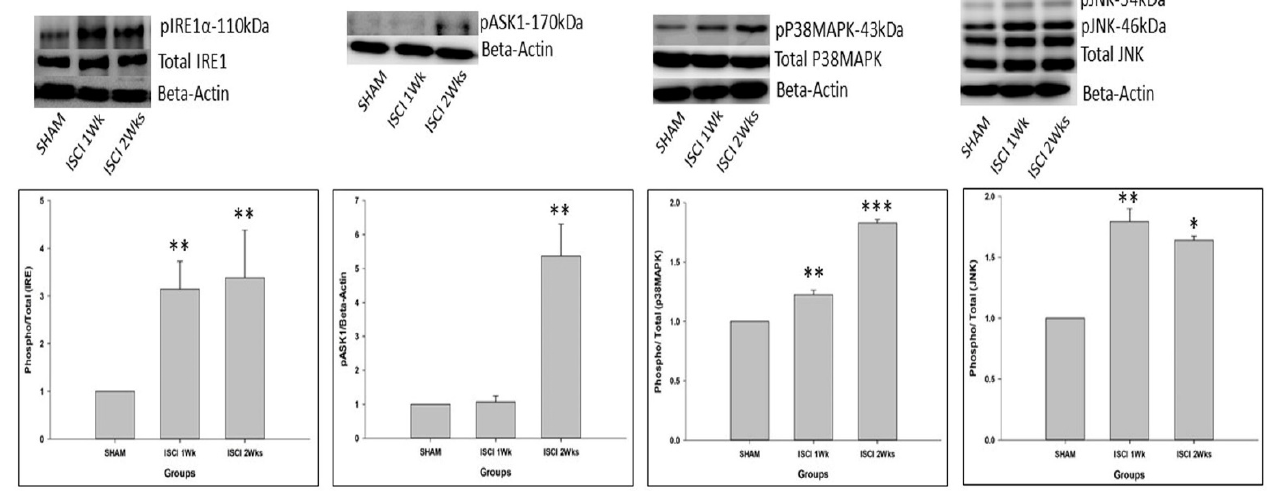
Figure 3. Western blot images with the quantification results showing the endoplasmic reticulum stress proteins by the IRE pathway. Data are expressed as mean ± standard error. * p < 0.05 versus the sham group; ** p < 0.01 versus the sham group; *** p < 0.001 versus the sham